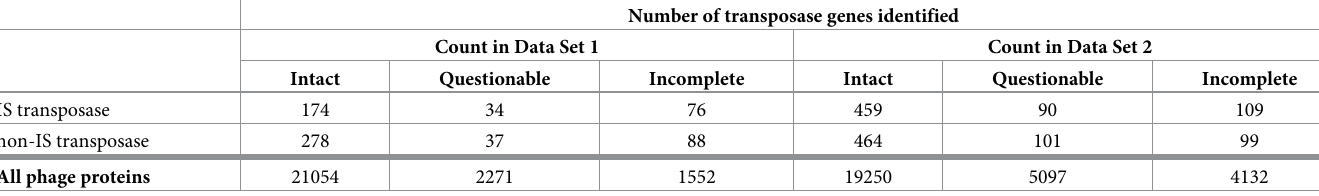
Table 2. The distribution of transposase genes identified in Data Set 1 and Data Set